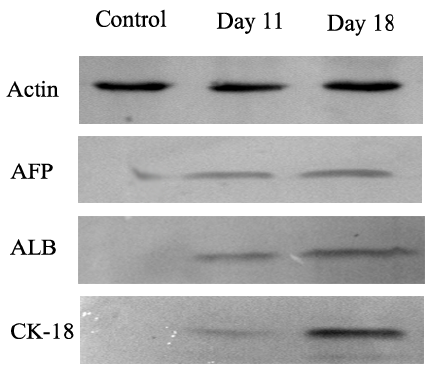
Figure 7. The expression of hepatocyte-specific markers by Western blot. Expression of hepatocyte-specific markers on undifferentiated (Control) and differentiated AD-MSCs α -fetoprotein (AFP), albumin (ALB) and cytokeratin